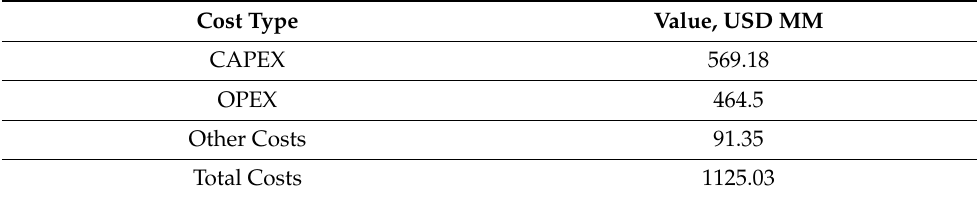
Table 1. The capital expenditure and operating costs of AA field.